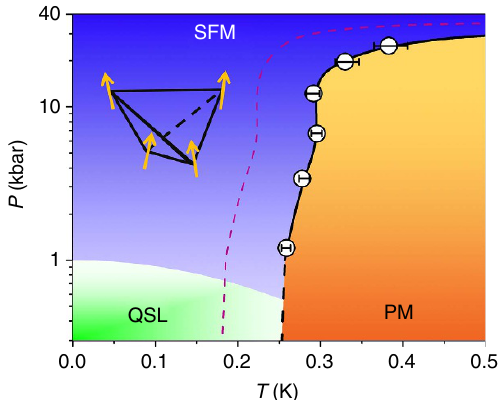
Figure 3 | Pressure–temperature phase diagram of Yb 2 þ x Ti 2 (cid:2) x O 7 þ d . The vertical axis displays the pressure P in logarithmic scale and the horizontal axis the temperature T . Empty black circles define the transition line between the collective paramagnetic (PM, orange) and the splayed ferromagnetic (SFM, blue) regions relative to the x ¼ 0 sample. The transition temperature is defined such that for T r T c 50% of the magnetic moments are frozen (see Fig. 2c). Error bars allow T c to be defined between 40 and 60% of the magnetic fraction. The green region highlights the presence of a disordered, non-magnetic phase (QSL) found at P ¼ 0. Black thick line is a guide to the eye. Dashed purple line is the hypothetical transition line for x ¼